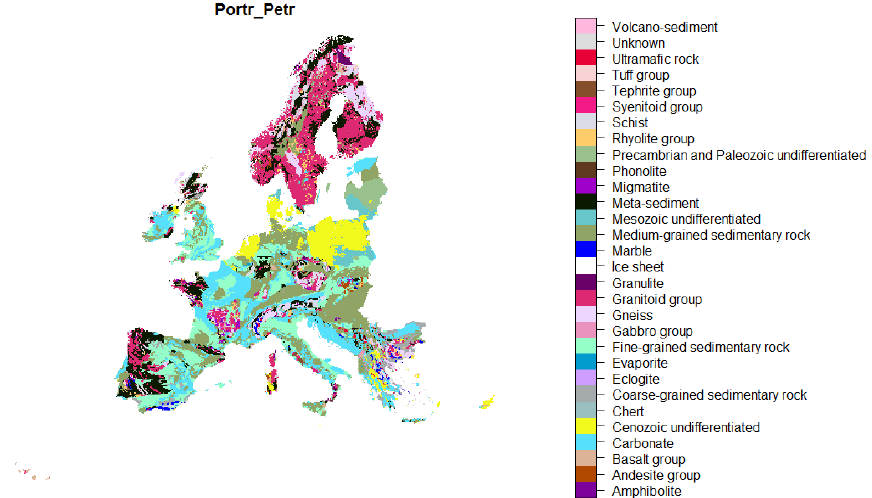
Figure 6. Simplified geology map with geological units defined on a lithology basis (Nogarotto et al., 2018). The base geological map is the IGME (Asch, 2003).